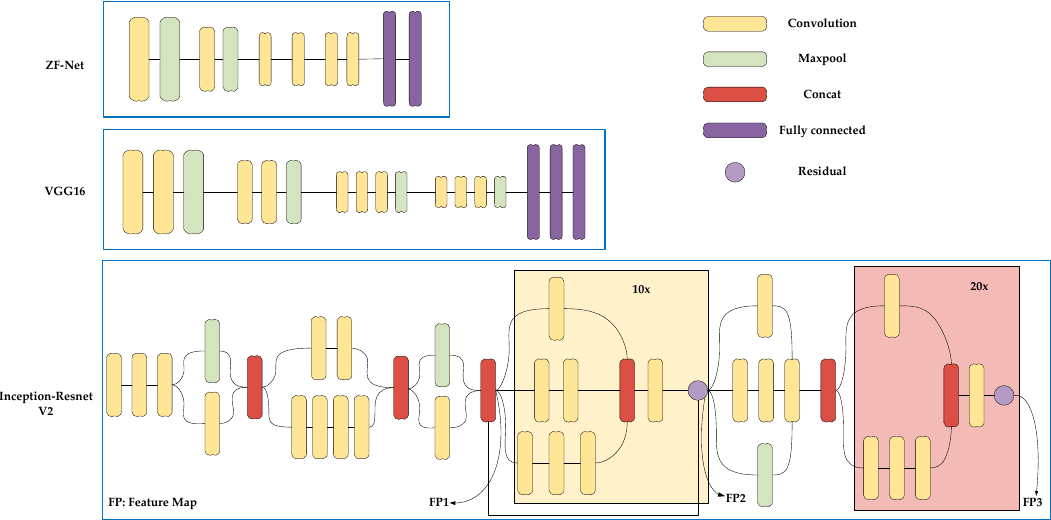
Figure 9. The three convolutional neural network (CNN) substructures.